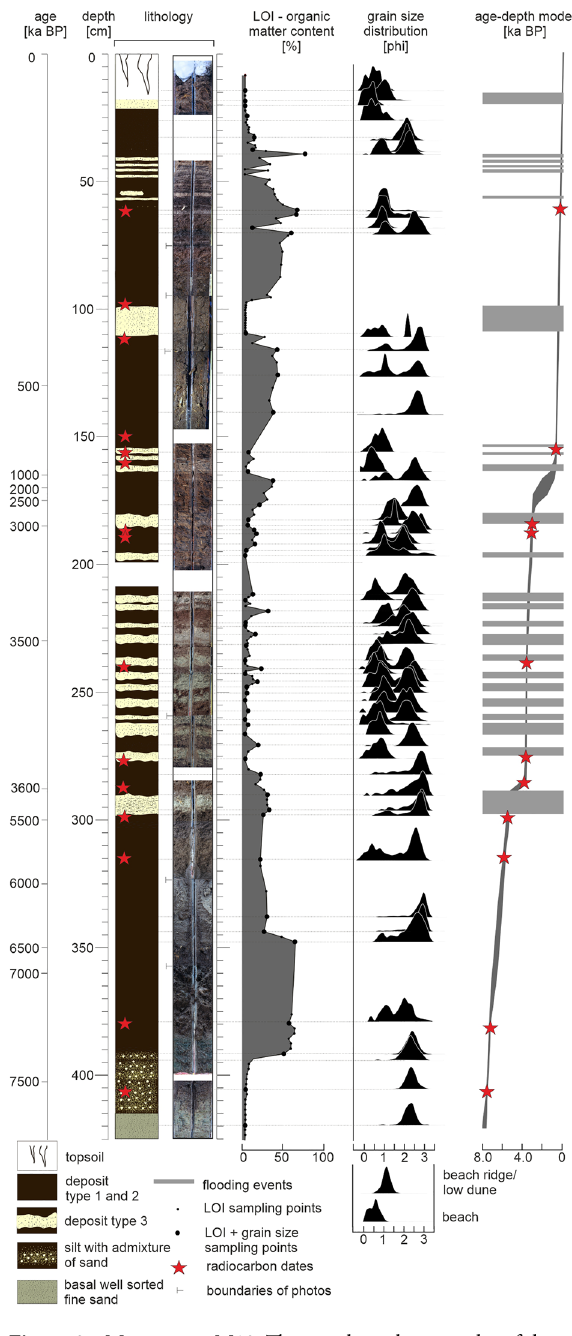
Figure 3. Master core M12. The core log, photography of the core, percentage of organic matter content, grain size distributions and age depth model. Depth scale was corrected for the mechanical compaction rate. See Fig. 1B for location of master core M12. Figure was created with CorelDRAW Graphics Suite 2019 (Corel Corporation: https:// www. corel. com/ en/ old- versi ons/ corel draw- 2019).